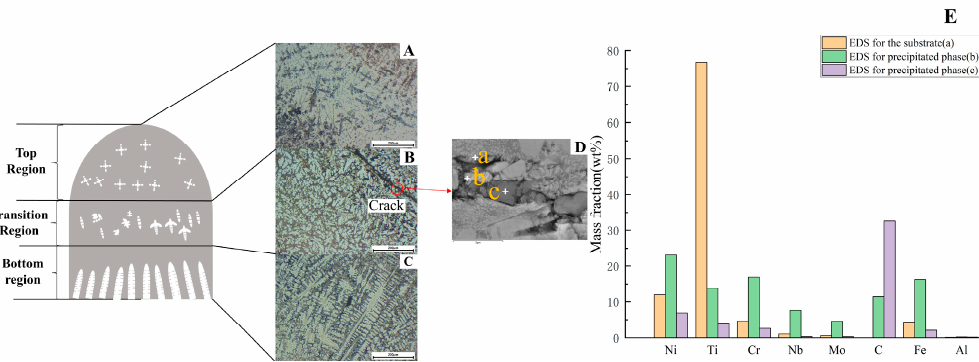
Figure 5. Double-layer sample characterization chart. ( A – C ) Optical microscope characterization. ( D ) EDS measurement elements. ( E ) Elemental content comparison chart (point a, b, c).